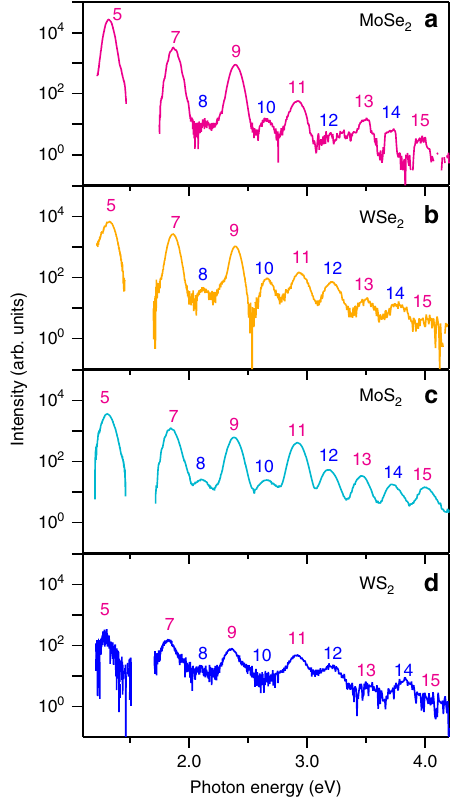
Fig. 1 High harmonic generation from monolayer TMDs. High harmonic spectra from a MoSe 2 , b WSe 2 , c MoS 2 , and d WS 2 monolayers at room temperature induced by mid-infrared pulse excitation (photon energy 0.26eV, peak intensity 1.7TWcm − 2 ). We set the excitation polarization in parallel with the zigzag direction. The harmonics from fi fth to sixteenth order are